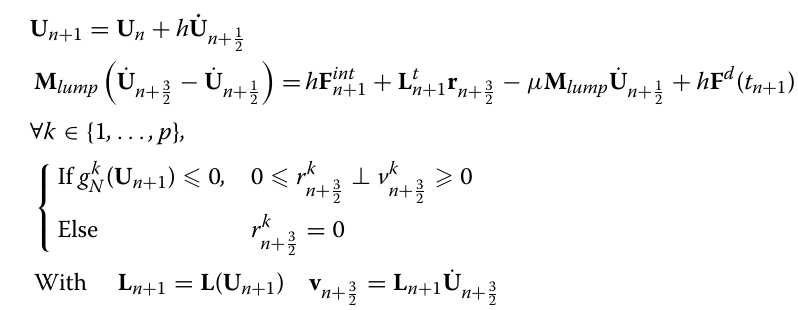
radius R and an angle sector θ . It is composed of 11 elements and defined by the following dimensionless